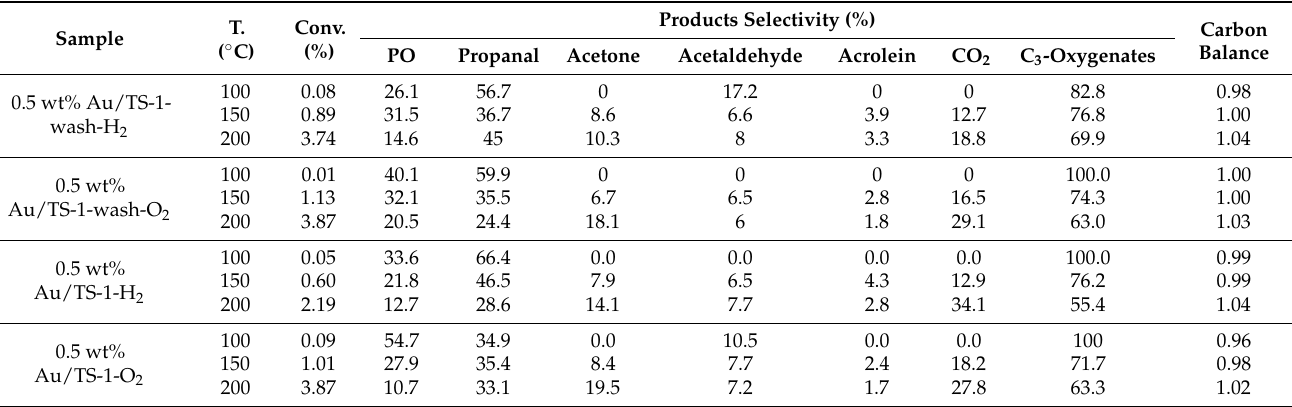
Table 1. Epoxidation of propylene on Au/TS-1 and Au/TS-1-wash under H 2 or O 2 pretreat- ment atmospheres.